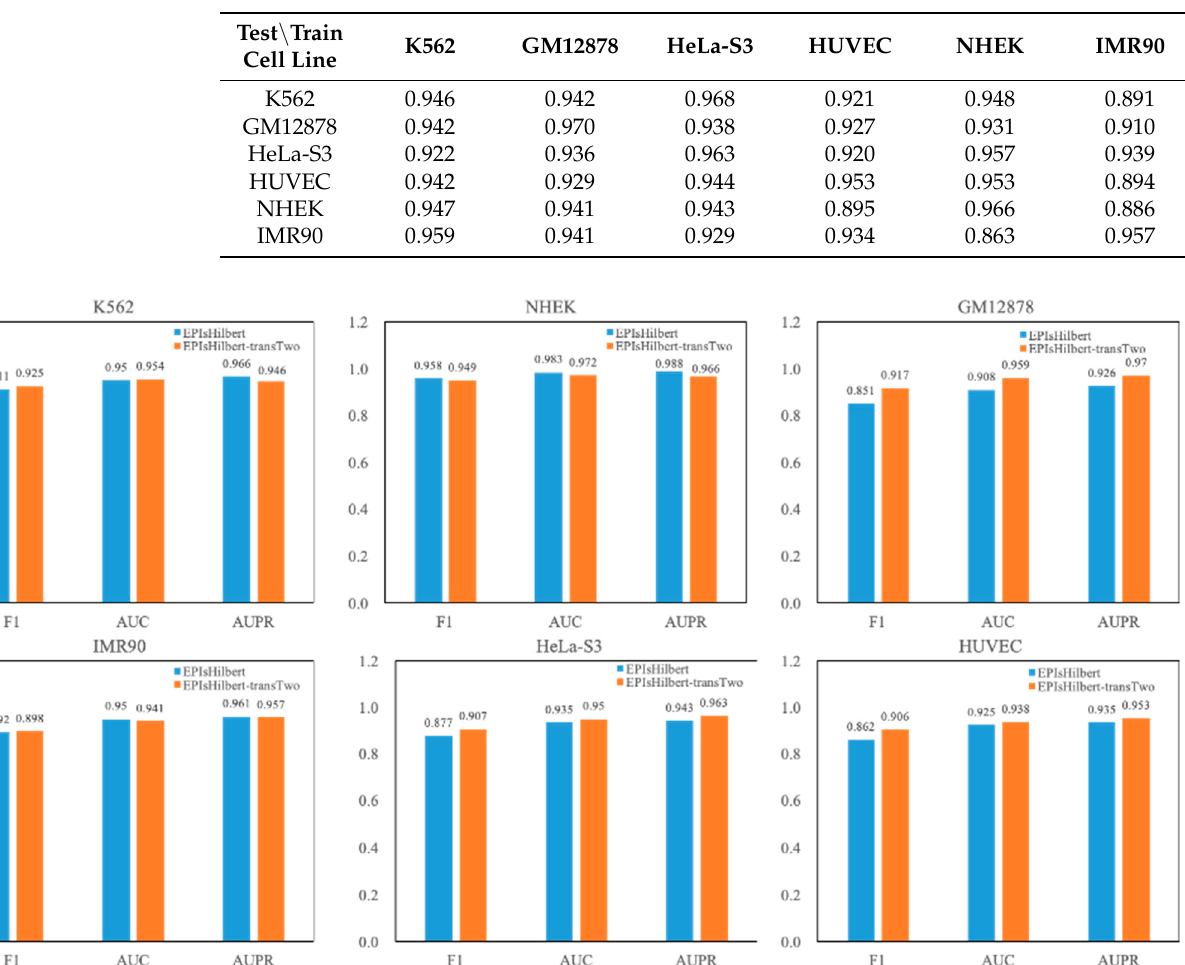
Table 5. AUPR value in EPIsHilbert-transTwo.